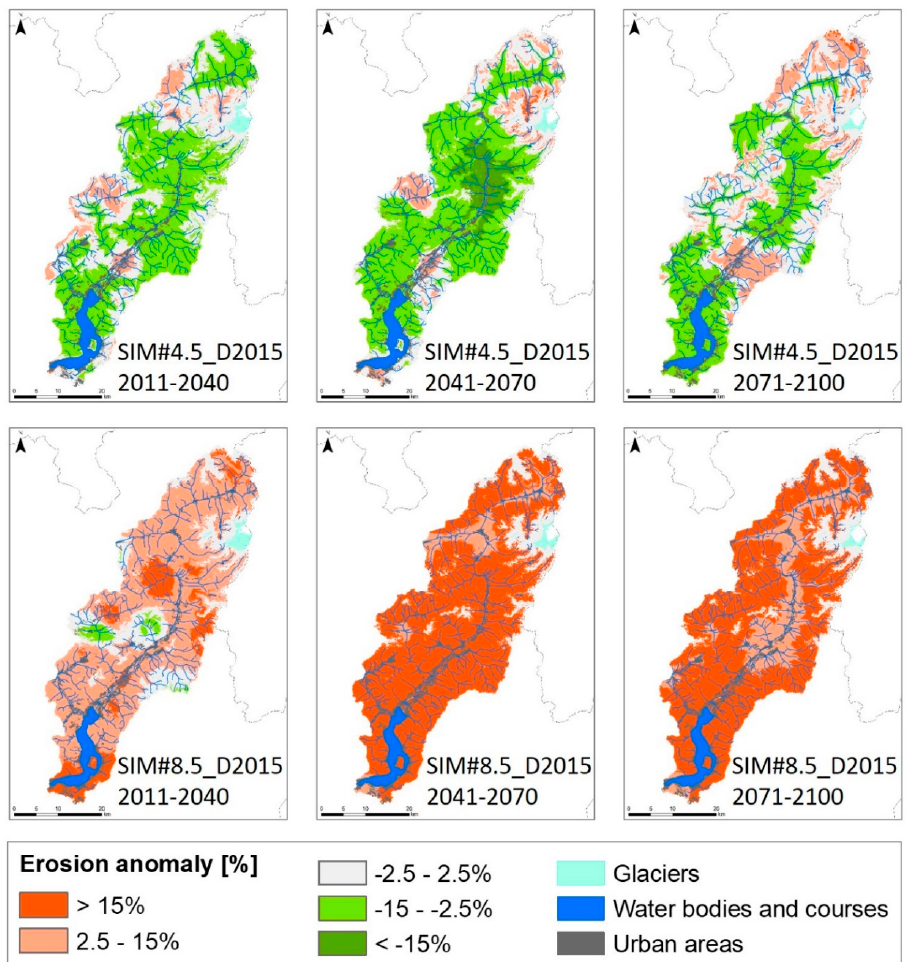
Table 7. Mean erosion rates [t ha -1 yr -1 ] according to climate projections.